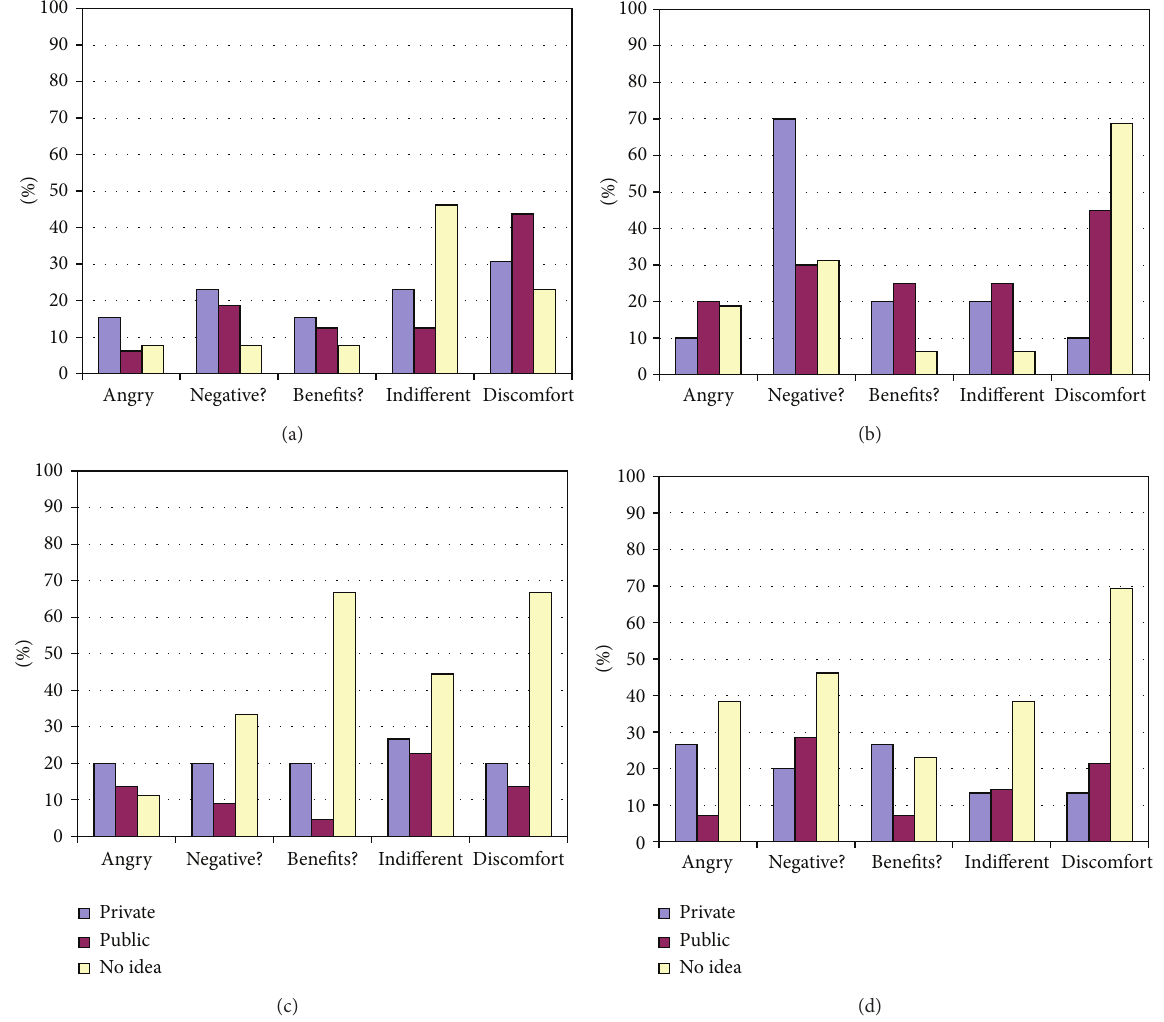
Figure 16: Reaction to be contacted according to the profile type: (a) DNs men; (b) DNs women; (c) DIs men; (d) DIs